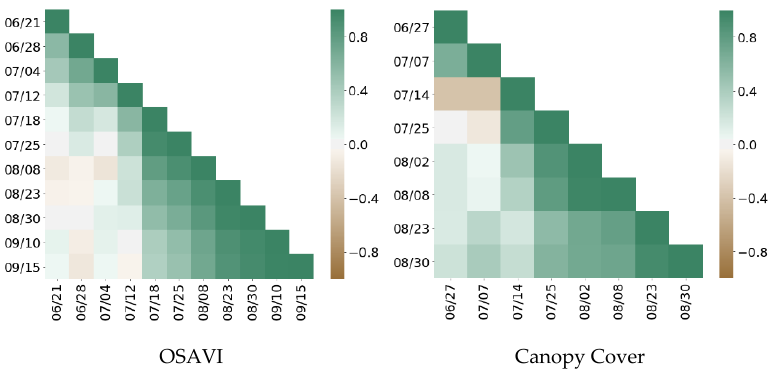
Figure 10. Correlation matrix calculated using all the remotely sensed hyperspectral data over the HyCal-17 experiment on different dates in the 2017 growing season. Note that as the light detection and ranging (LiDAR) and hyperspectral sensors were flown on separate platforms, the number of available data sets differs, and the data were not always collected on the same day.